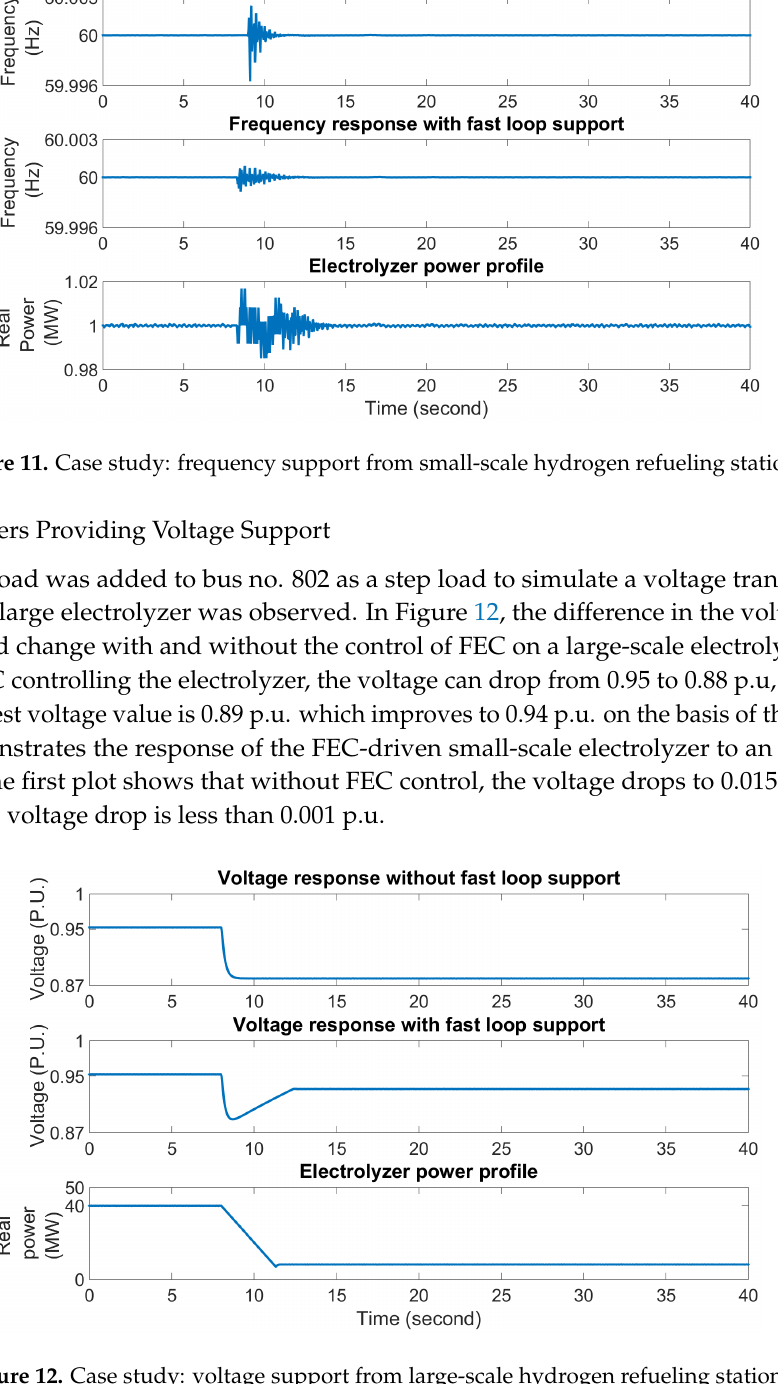
Figure 12. Case study: voltage support from large-scale hydrogen refueling